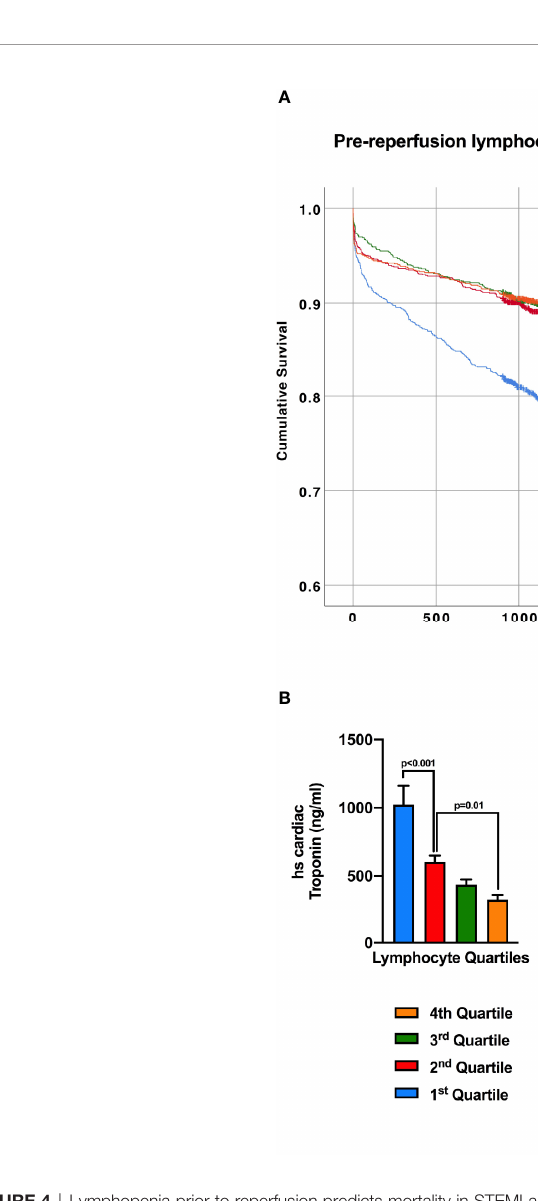
FIGURE 4 | Lymphopenia prior to reperfusion predicts mortality in STEMI and is associated with admission troponin. (A) Kaplan-Meier survival curves of 4874 consecutive STEMI/pPCI patients discharged alive following pPCI (mean follow-up time of 7.5 years), divided into four quartiles of pre-reperfusion lymphocyte count, with the lowest quartile having worse survival. Survival of each quartile was compared with unadjusted Kaplan-Meier analysis. (B) The same 4874 patients, with the mean admission high-sensitivity cardiac troponin T value (ng/ml) for each lymphocyte quartile, showing that patients with the lowest lymphocytes had the highest troponin values (statistical comparison by unpaired t-tests). (C) Correlation between pre-reperfusion lymphocyte count and left-ventricular ejection fraction between 2-7 days post-reperfusion. Lower lymphocyte count was predictive of worse ejection fraction only in CMV seronegative